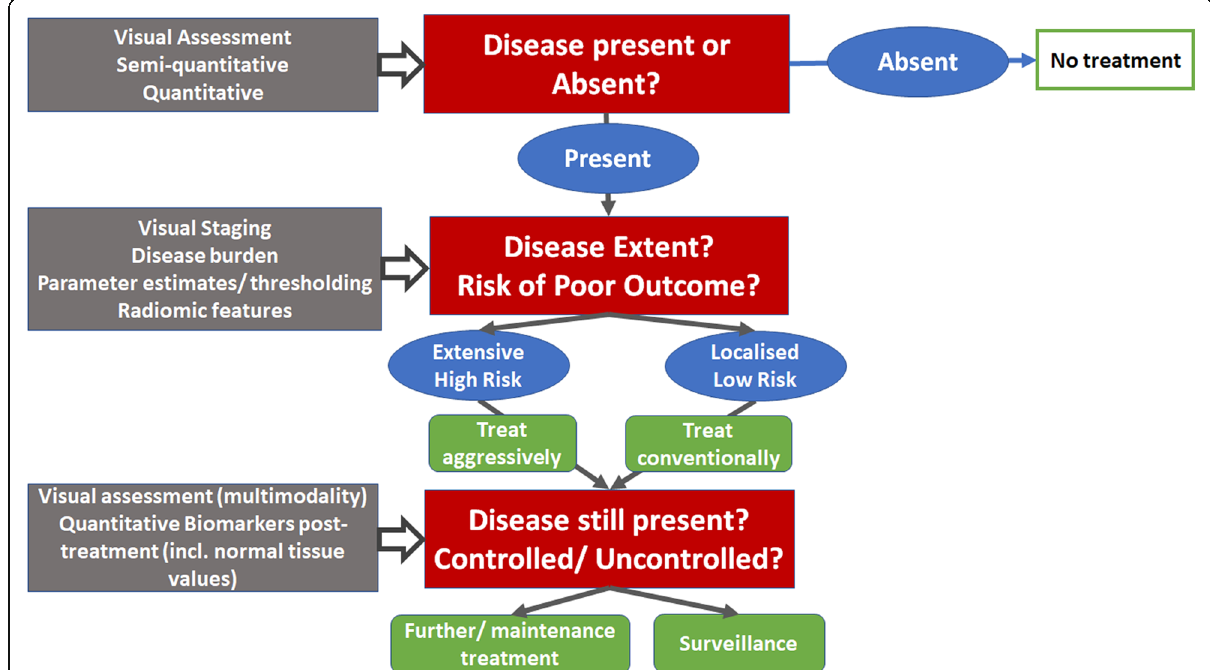
Fig. 1 Schematic of questions requiring decisions (red boxes), imaging assessments (grey boxes), the results of the imaging assessments (blue ovals) and the management decisions they potentially influence (green